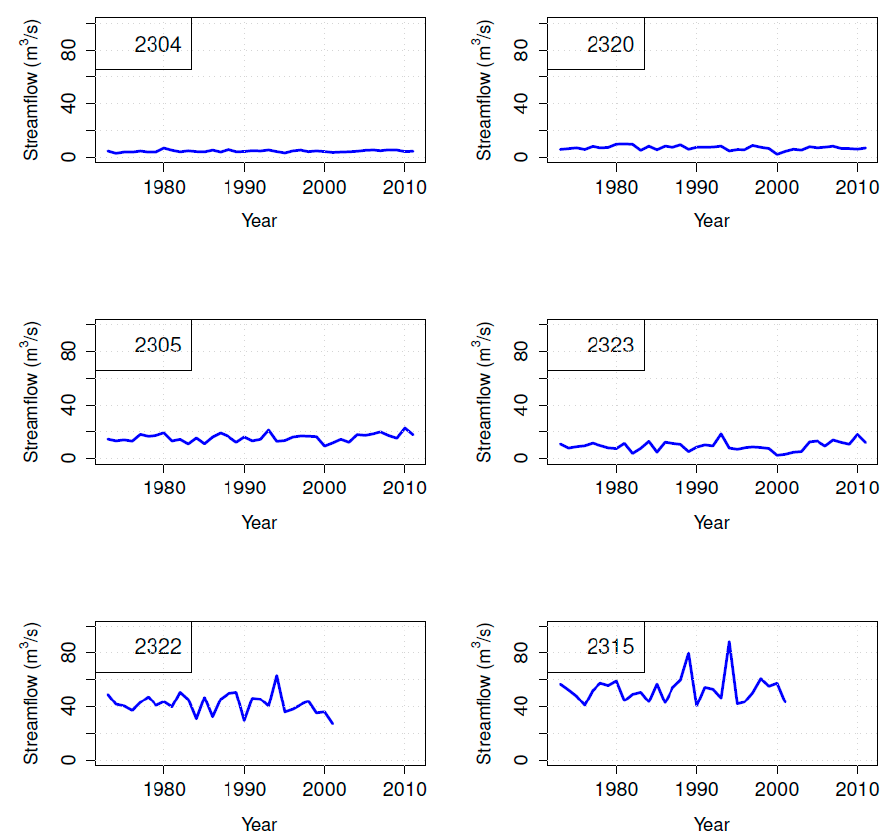
Figure 2. Time series of the 7-day low-flow data series used: the labels indicate the station’s codes.